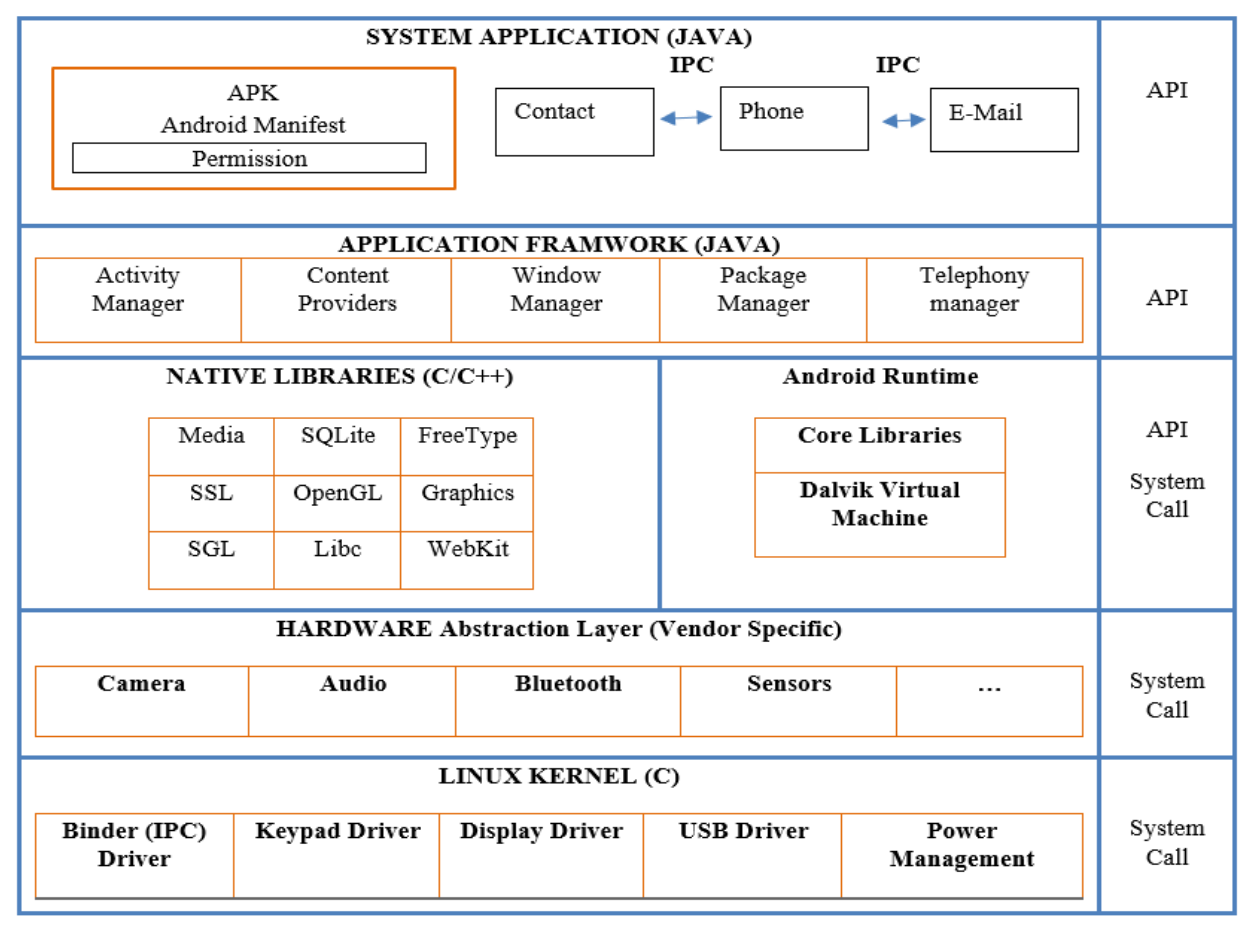
Figure 3. Android framework layers.